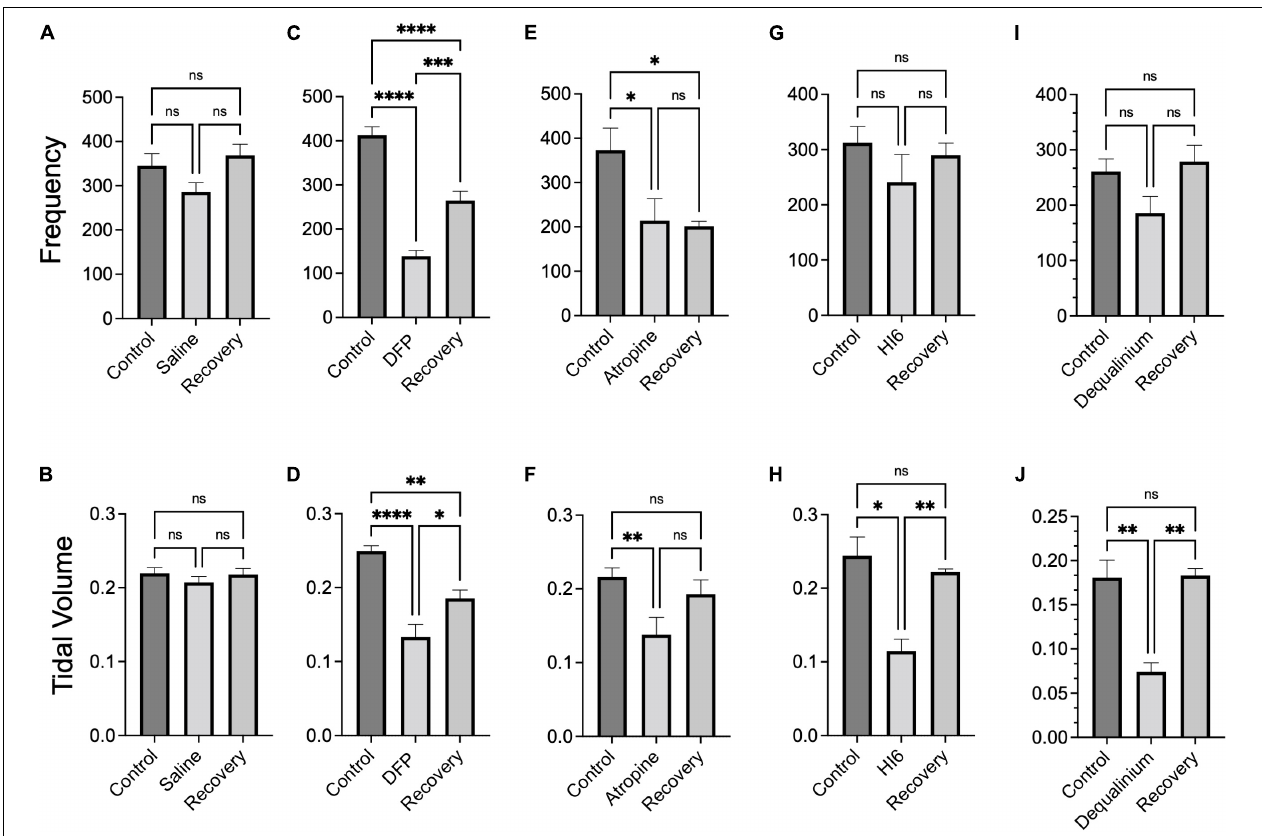
FIGURE 4 | Summary breathing frequency (breaths per minute) and tidal volume (ml) changes in response to diisopropylfluorophosphate (DFP) alone or DFP with treatments. Bar graphs show average breathing frequency (top panels) and tidal volumes (bottom panels) before (control), acutely after DFP or DFP with treatment (middle bar) and 22–24 h after treatment (recovery). Data is the average across the last 5 min of 1 h measurements (data from Figure 3 ) of breathing frequency and tidal volume, respectively, for saline treatment (A,B) , DFP alone treatment (C,D) , DFP with Atropine (E,F) , DFP with HI6 (G,H) , and DFP with dequalinium chloride (I,J) . Data is for analysis of 10 mice for saline alone, 10 mice for DFP alone, seven mice for DFP with atropine, eight mice for DFP with HI6, and four mice for DFP with dequalinium chloride. Statistical significance was determined with one-way ANOVA comparison between treatments. Significance of < 0.05, p < 0.01, p < 0.001 is indicated with single, double, and triple asterisks,